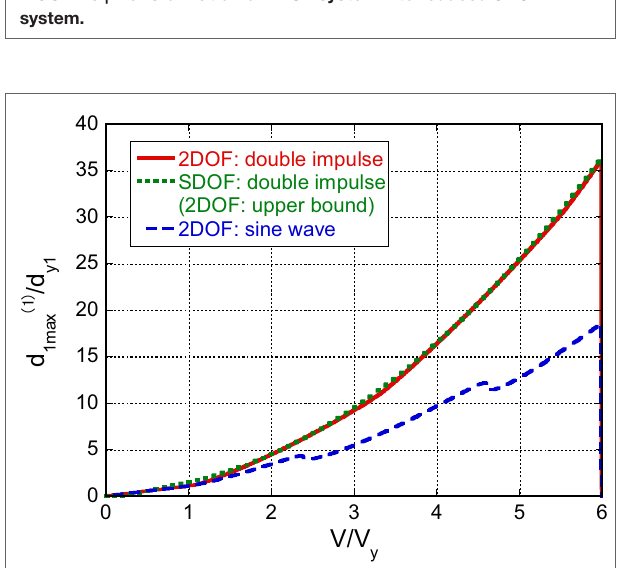
FigUre 10 | Maximum interstory drift after the first impulse in the first story together with the response of the sDOF system (also upper bound of 2DOF system) and the response under the corresponding one-cycle sinusoidal wave.